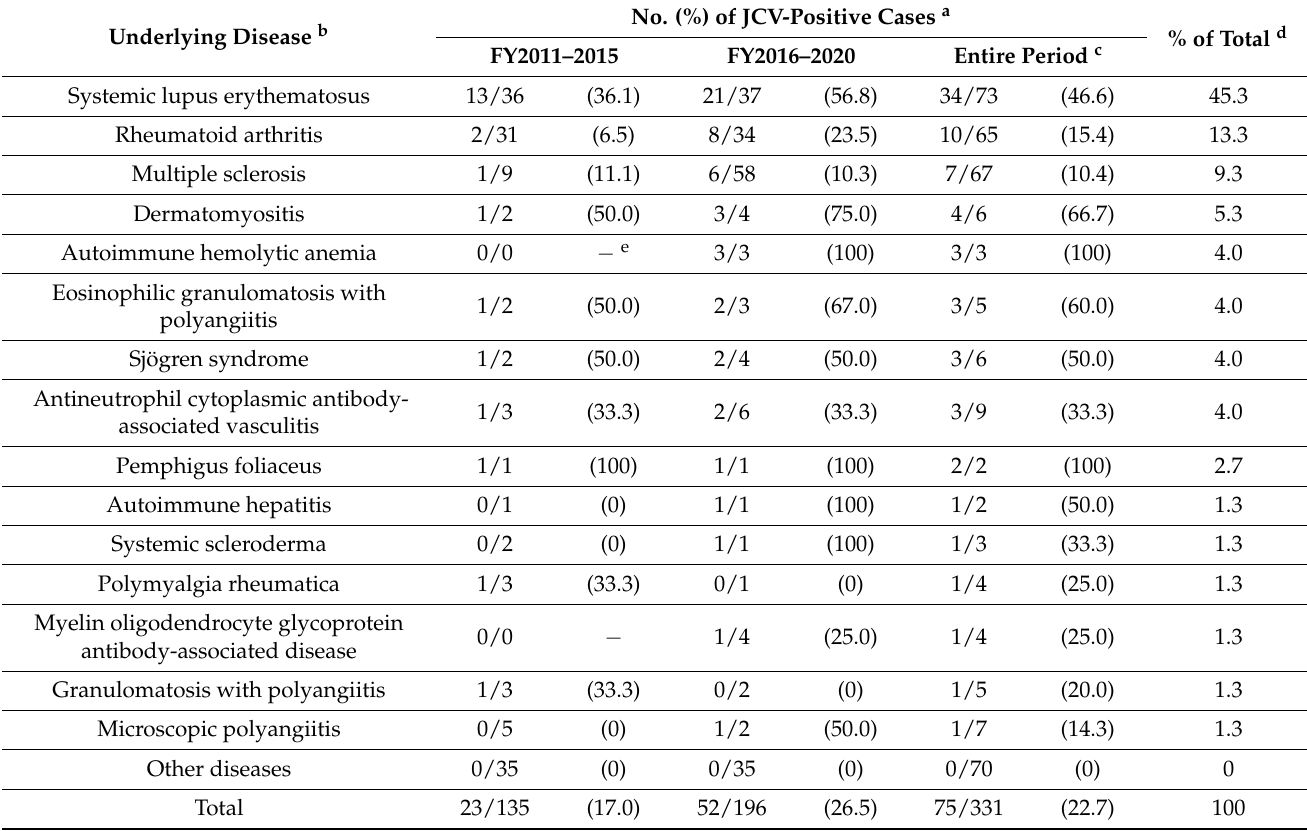
Table 3. PCR-based detection of JCV in CSF specimens from patients with autoimmune disorders. Underlying Disease